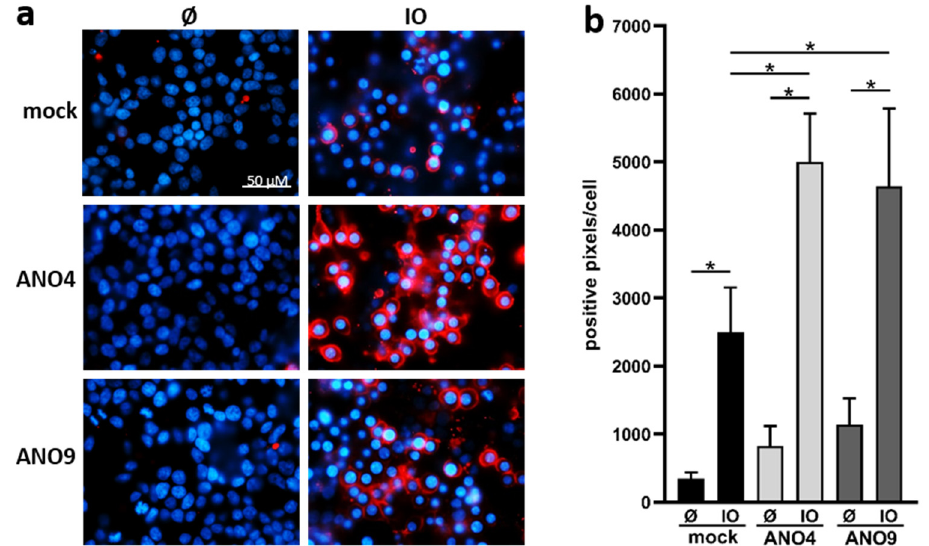
Figure 4. Ionomycin induces increased phosphatidylserine (PS) exposure in ANO4- or ANO9-overexpressing cells. ANO4- or ANO9-transfected HEK293T cells were stimulated with IO (1 µM) for 30 min. After stimulation, cells were stained with Annexin V-AF568 (red). Nuclei were counterstained with Hoechst (blue). Representative images of six independent experiments are shown ( a ). The fluorescence was quantified for statistical analysis ( b ). * indicates a significant increase (n = 6; * p < 0.05; ± SEM). Data were analyzed by one-way ANOVA and Holm–Sidak multiple comparison post hoc test.